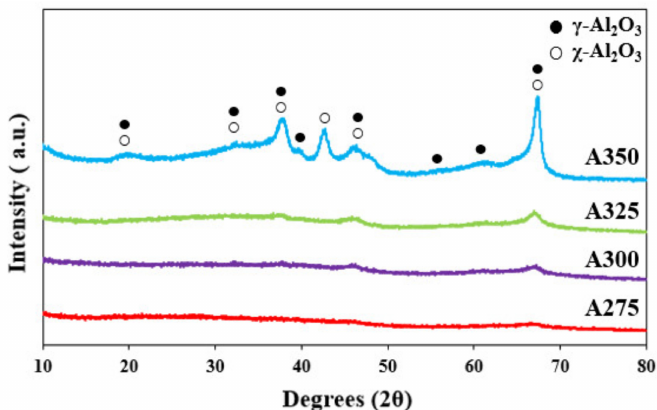
Figure 2. XRD patterns of the alumina samples A275, A300, A325, and A350 prepared at 275 ◦ C, 300 ◦ C, 325 ◦ C, and 350 ◦ C, respectively.